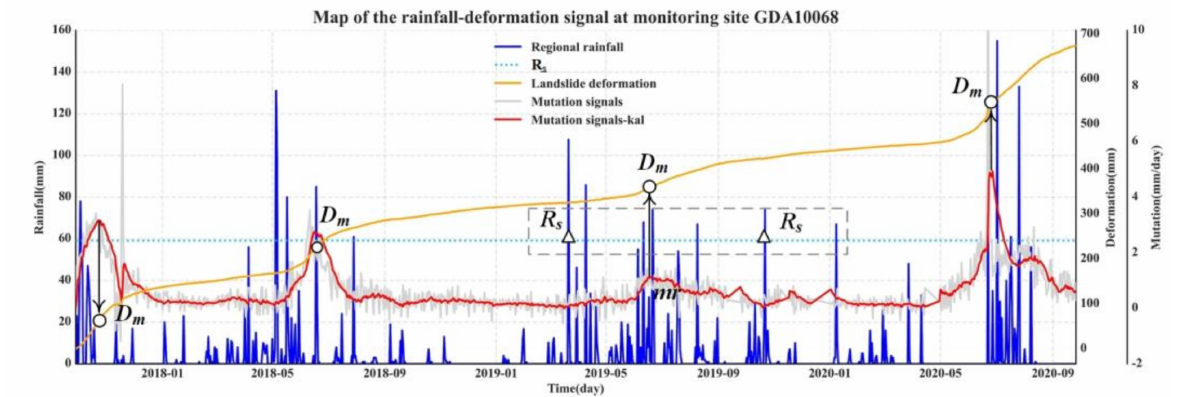
Figure 7. Map of monitoring data at landslide site GDA10068. Used to calculate rainfall-induced deformation value, mutation signals, and the corresponding Kalman filter